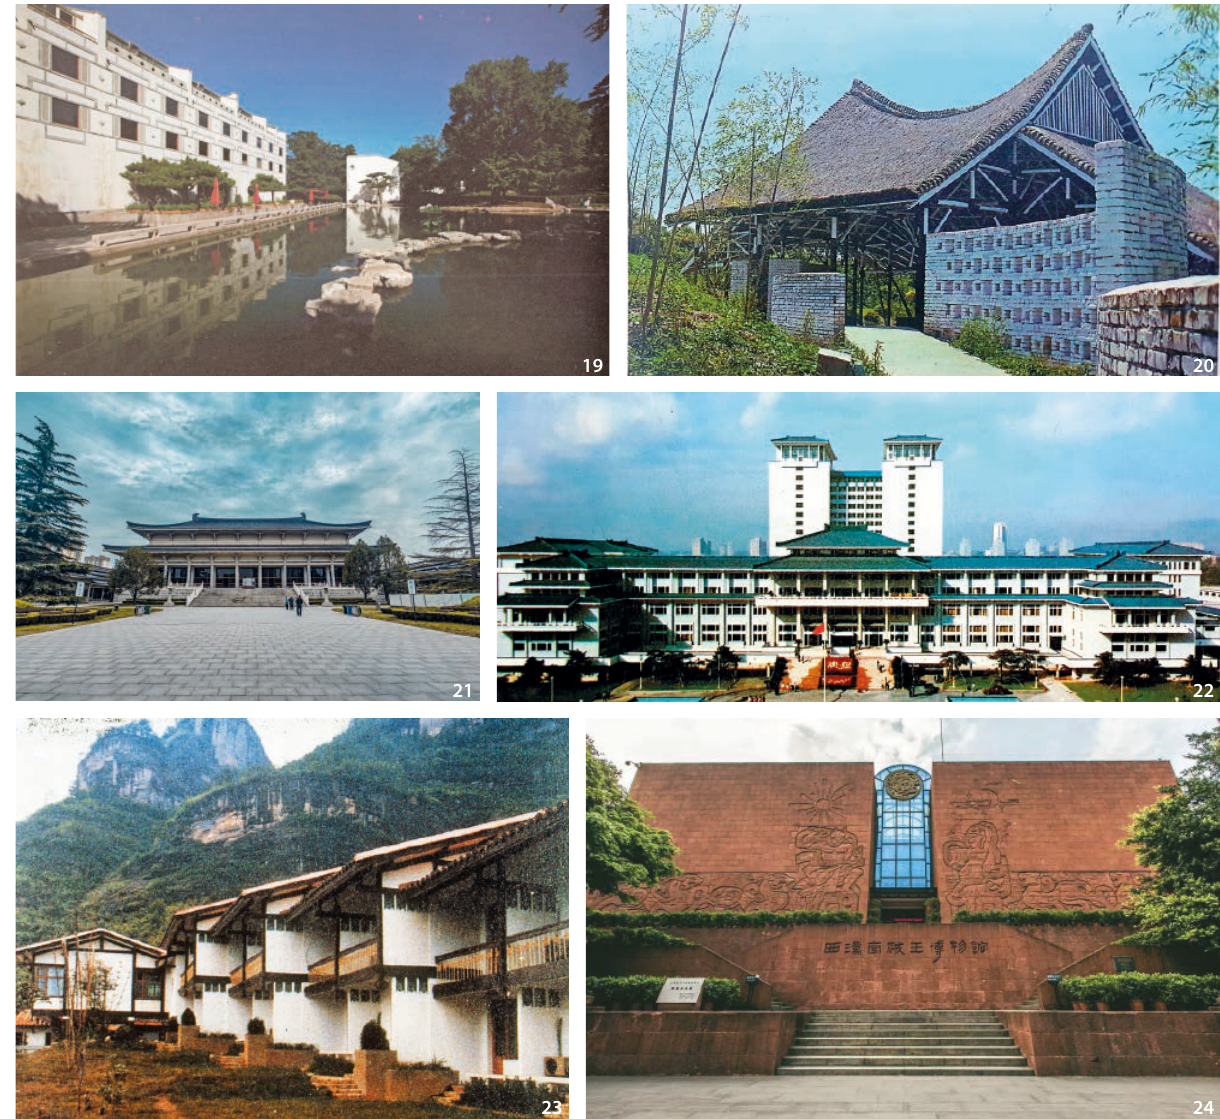
Figure 19 Fragrant Hill Hotel in Beijing, 1982 (Source: CRC, ASC, and CSCR-C20C 2016, 216). Figure 20 Helou Pavilion in the Square-Pagoda Garden in Songjiang District, Shanghai, 1986 (Source: Xiao 1990, 132). Figure 21 Shaanxi History Museum, 1991 (Source: Yao Qi) Figure 22 The National Library of China, Beijing, 1987 (Source: Xiao 1990, 13) Figure 23 Wuyi Mountain Villa, Fujian, 1983 (Source: Xiao 1990, 88) Figure 24 Museum of the Nanyue King of Western Han Dynasty, 1988 (Source: